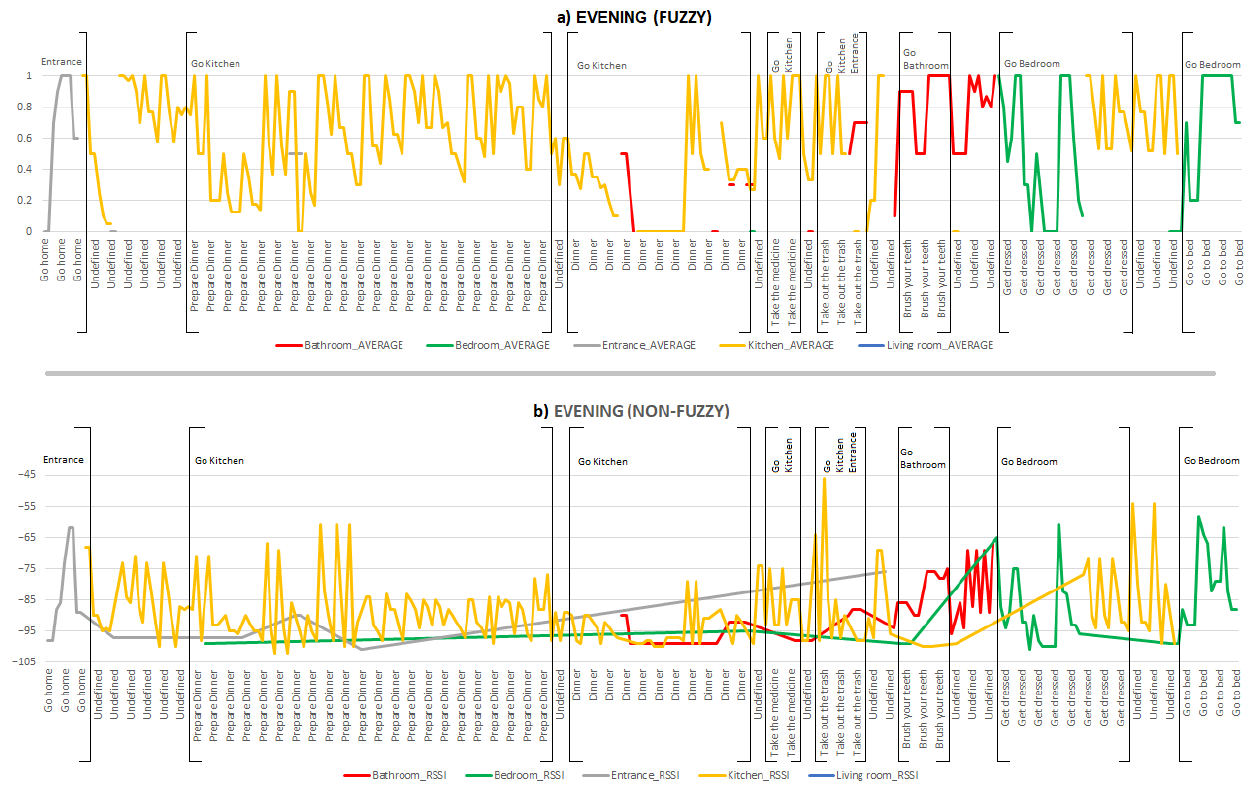
Figure 7. Areas visited and activities carried out by the inhabitant during the evening ( a ) with fuzzy processing and ( b ) non-fuzzy (raw